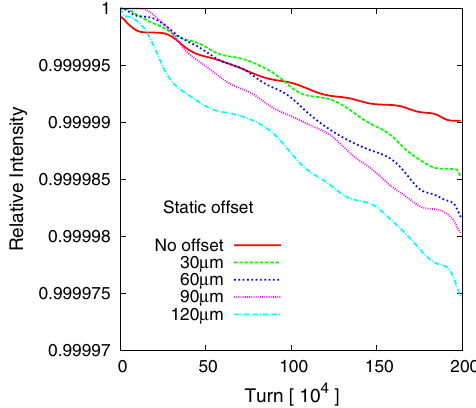
FIG. 21. Relative proton beam loss with the truncated Gaussian tail of the electron beam. Simulation of the electron gun for the RHIC e-lens system shows that the electron beam has a Gaussian tail cutoff at 2 : 8 (cid:5)